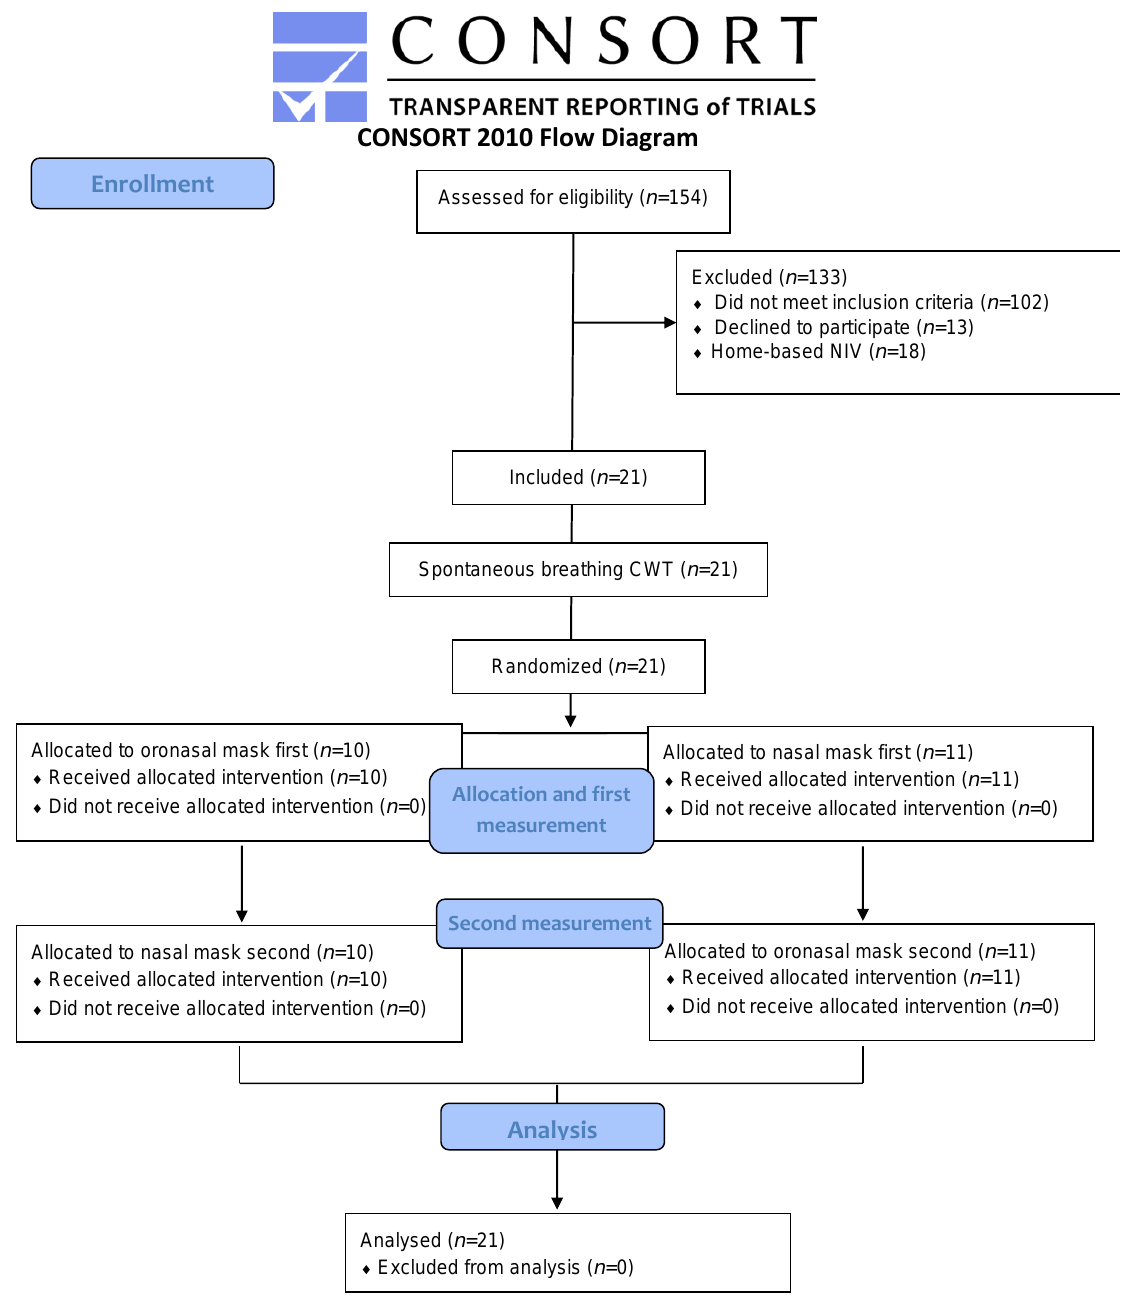
Figure 1. Flow-chart. NIV: noninvasive ventilation; CWET: constant workload exercise testing. Patients characteristics are shown in Table 1. Nine (43%) were female and five (24%) were long term oxygen users. All had severe obstruction (mean FEV1%: 35.3% (±8.3)), were severely hyperinflated (mean RV/TLC: 0.6 (±0.1) and had impaired exercise capacity (mean VO2peak: 12.1 mL/kg/min (±2.8).